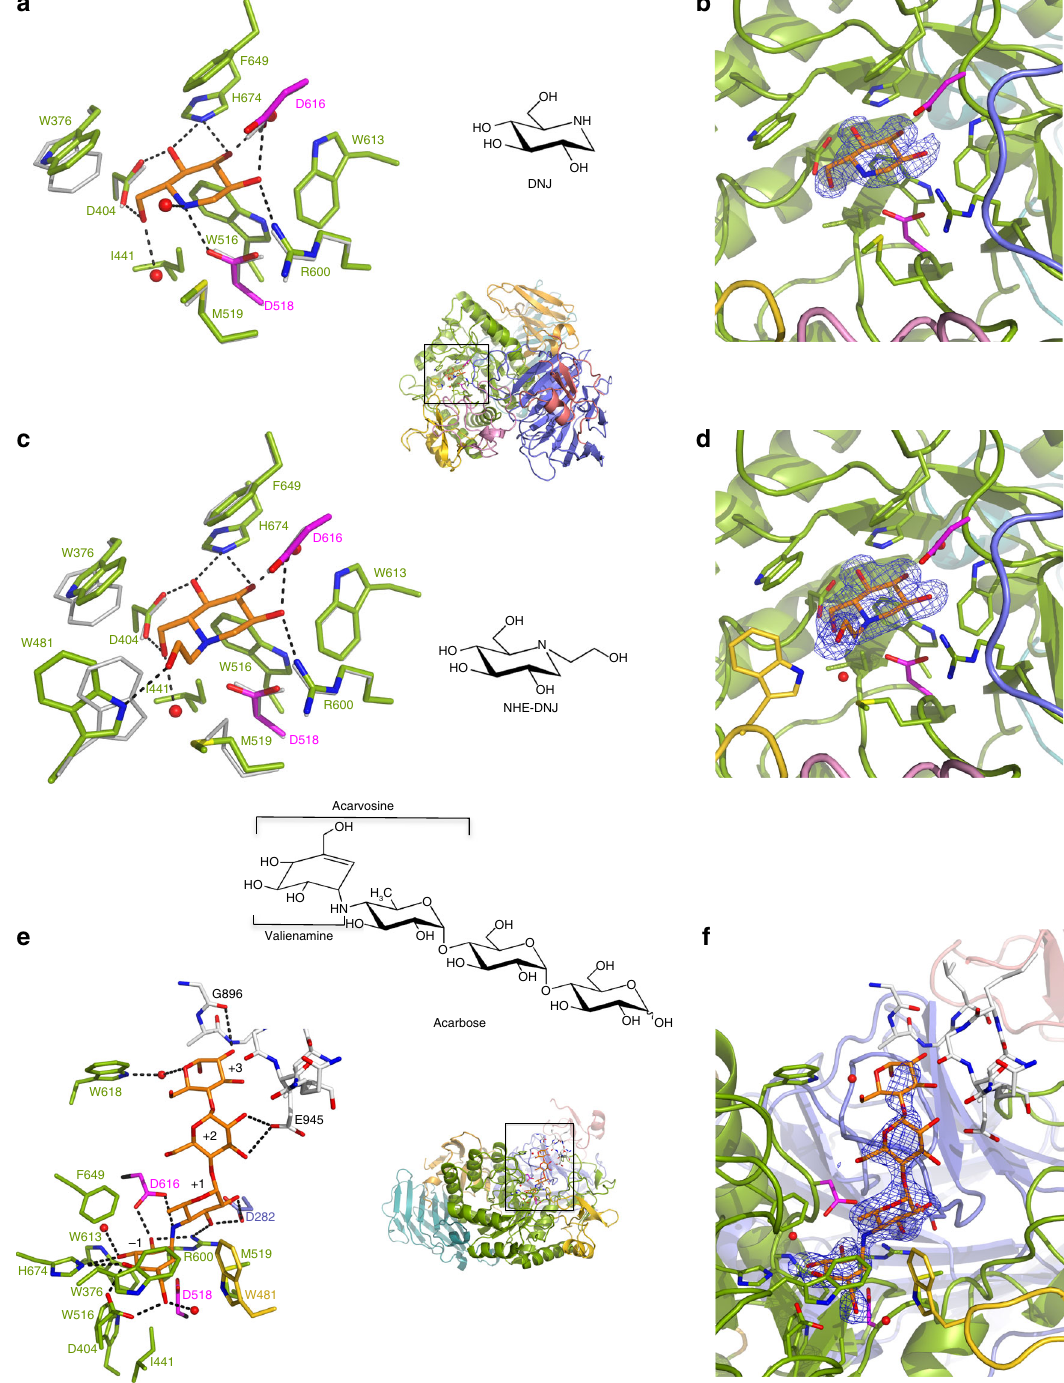
Fig. 3 Ligand binding to rhGAA. DNJ ( a ), NHE-DNJ ( c ) and acarbose ( e ) colored in orange bound to rhGAA, color-coded as in Fig. 2c, overlapped onto unbound rhGAA (grey) in ( a ) and ( c ). Hydrogen bonding interactions are represented as dashed lines. In e , substrate-binding subsites are numbered and residues of a symmetry-related molecule are depicted in white sticks. Unbiased F o – F c difference electron density maps, calculated before incorporation of the ligands into the models and contored at 3.0 σ , are shown in b , d and